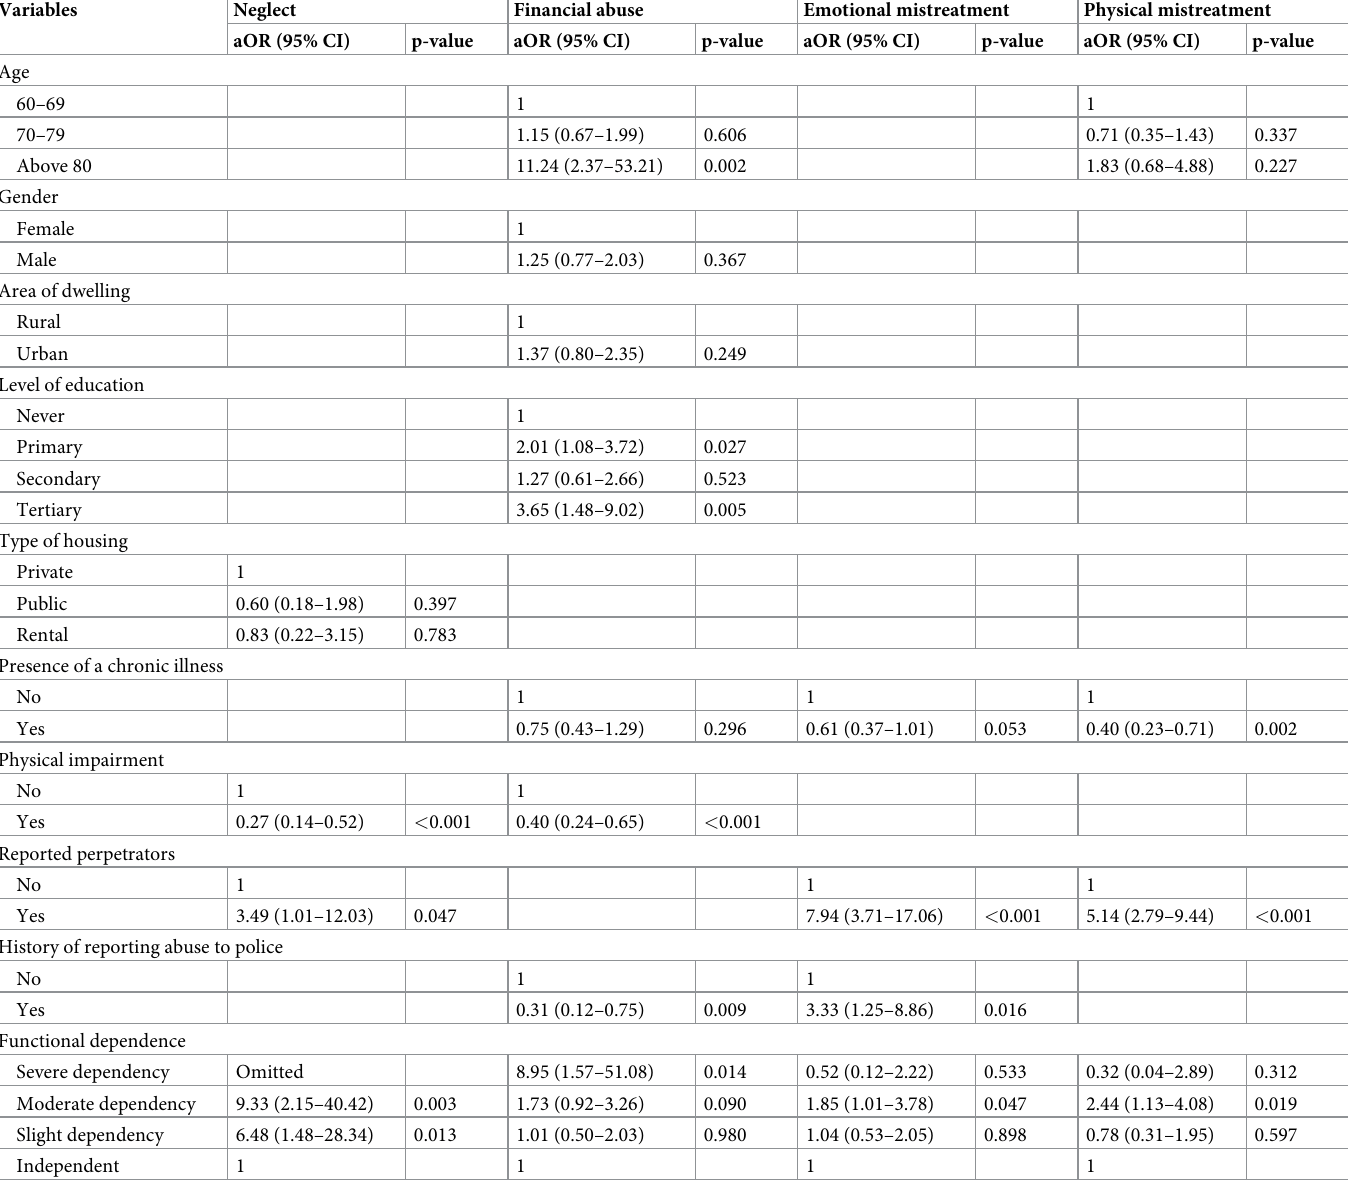
Table 5. Multivariable logistic regression analysis for factors associated with the different types of